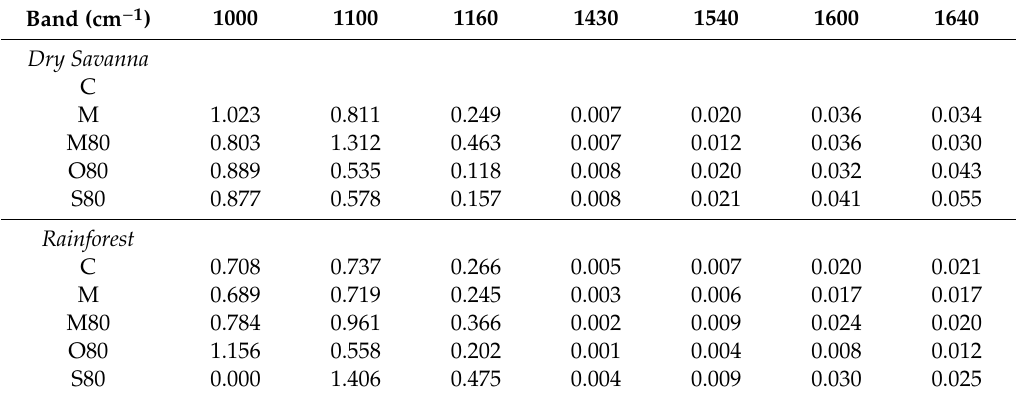
Table A1. The abundance of di ff erent C functional groups in the soil samples before planting (BP) as estimated using the absorbance intensities of the ATR-FTIR bands.